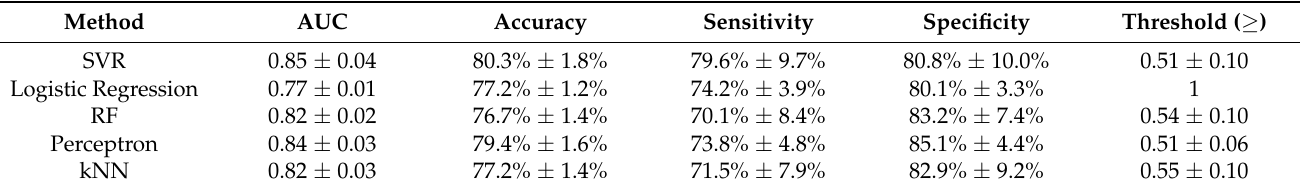
Table 3. Performances of various models in discriminating between stage T1 nasopharyngeal carci- noma (NPC) and benign hyperplasia in T2-weighted, fat-suppressed MRI. The accuracy, sensitivity, and specificity were evaluated using the threshold determined by the point maximizing the Youden index in the corresponding fold. As logistic regression returned binary results in our implementation, its threshold is effectively ≥ 1 for NPC.